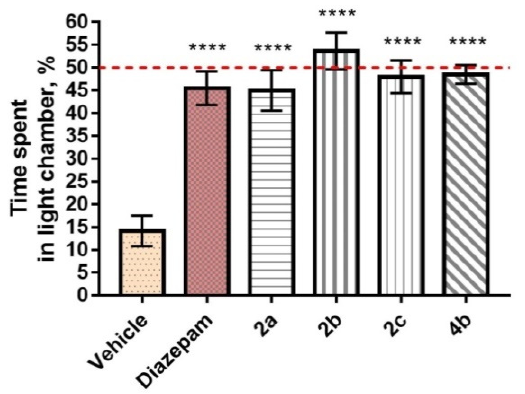
Figure 3. Anxiolytic activity of leader compounds in Light/dark box test in comparison with diazepam (1 mg/kg), mice, per oral administration, M ± SEM. Note: **** Data are comparable to the control group ( p < 0.0001, one-way ANOVA post-hoc Dunnett’s test).